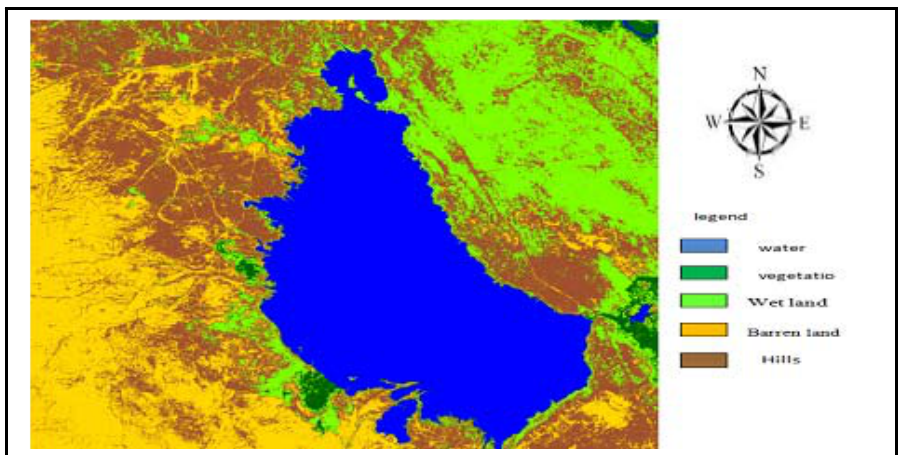
Fig.11: Unsupervised classification using K-Means classification method for Landsat-5 (1990).